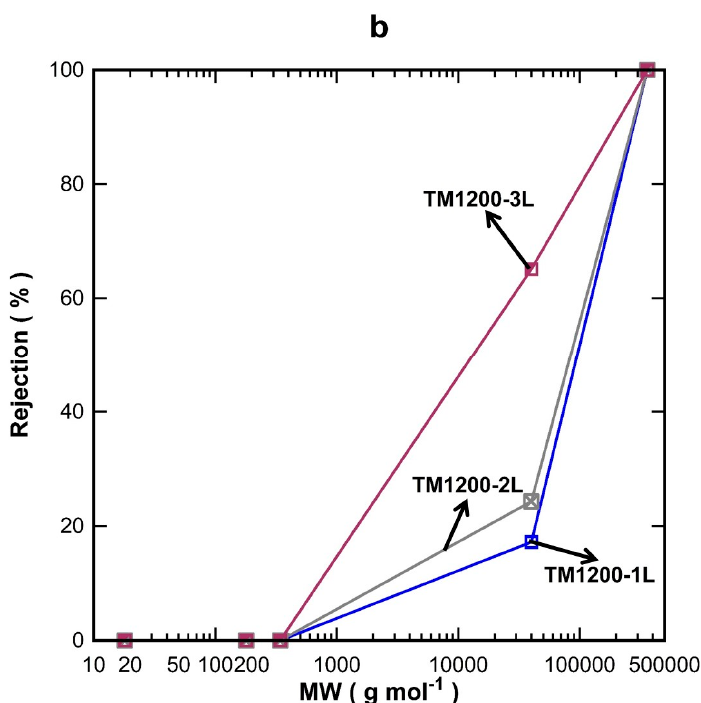
Figure 5. MW cut off performance of TM1200 membranes prepared with varying numbers of titania layers ( a ) flux and ( b ) percentage of rejection as a function of MW.